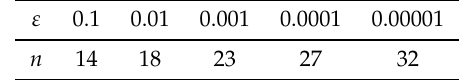
Table 3. Number n of iterations needed by the a posteriori estimate if started with ( 100,20 ) .